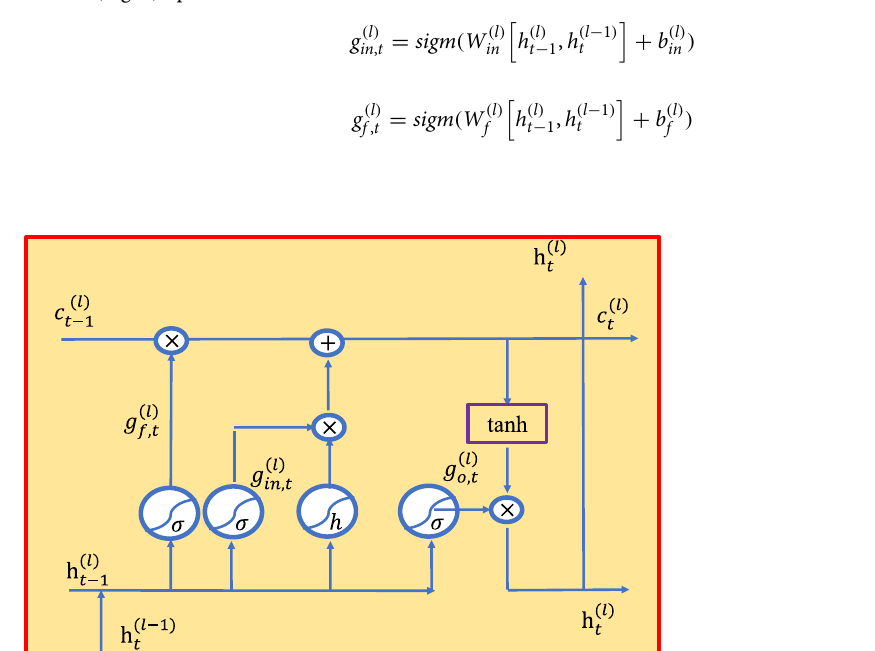
g ( l ) f , t represents the forget